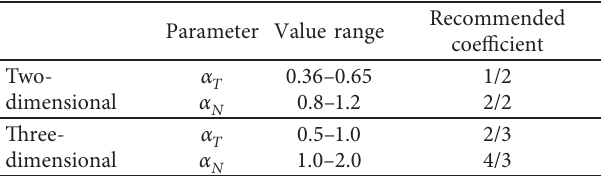
Figure 8: Wheel-rail contact. Table 4: Value range for the viscoelastic artificial boundary